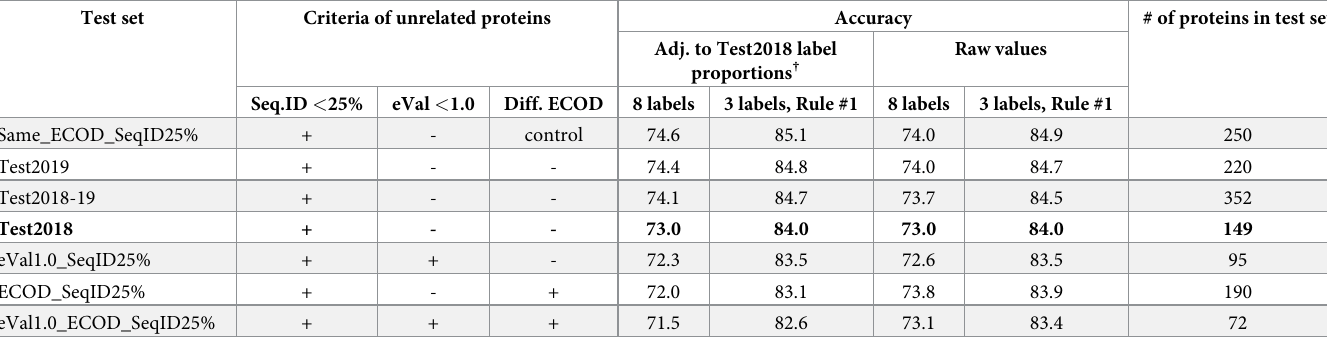
Table 9. Prediction accuracy of our SecNet software trained on Set2018 and tested on sets with stricter criteria of unrelated proteins. Test